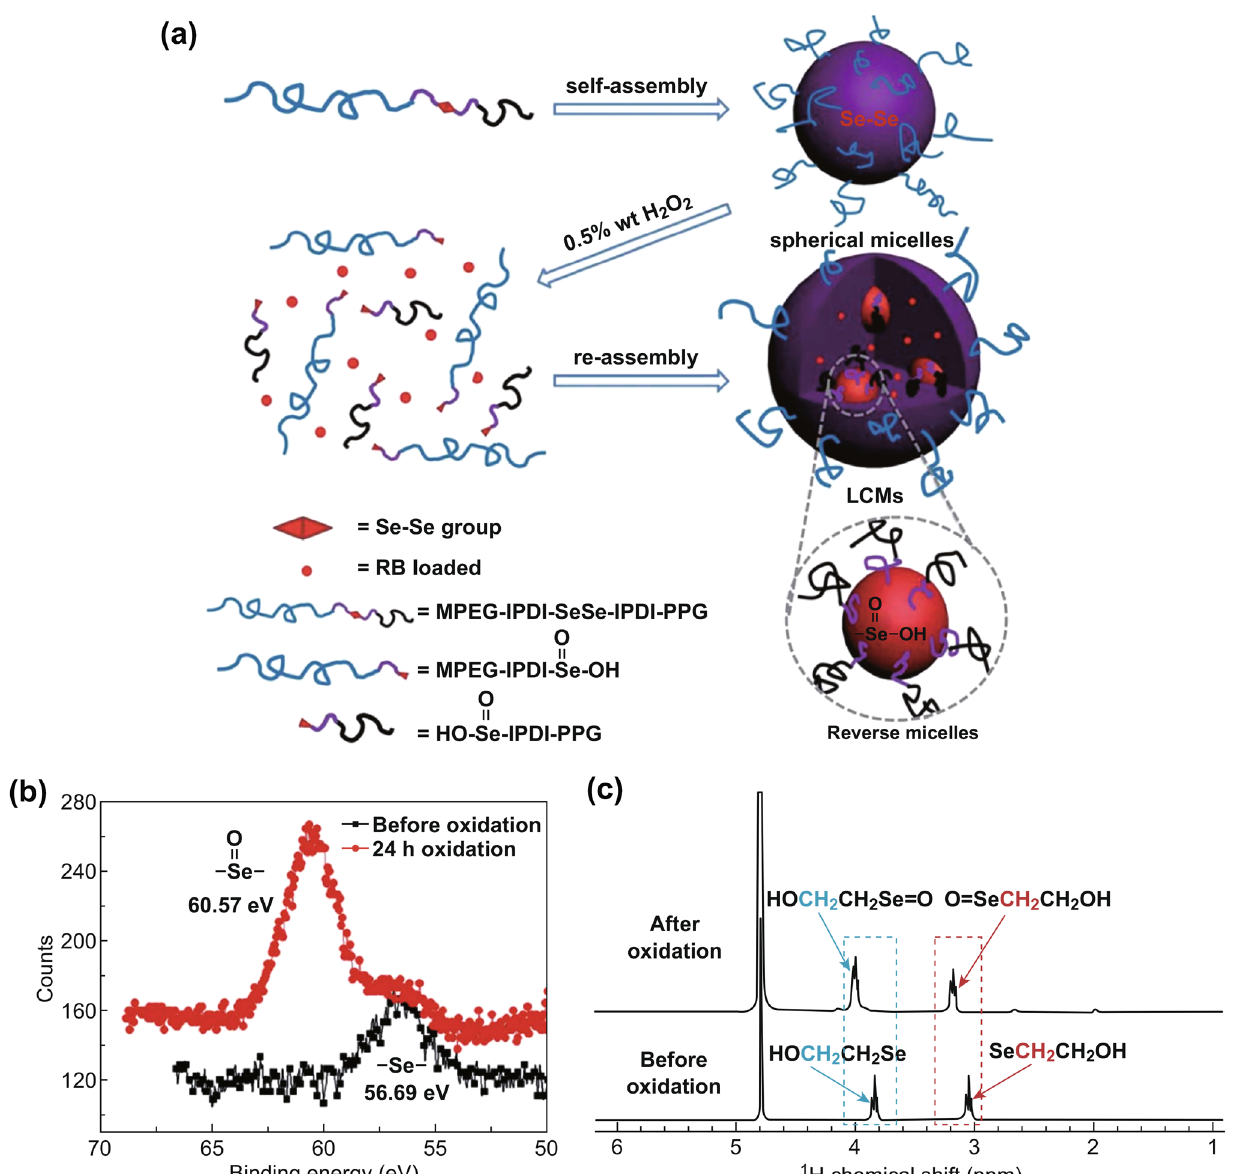
Fig. 12 a Schematic of the oxidation-responsive morphological transformation of MPEG-IPDI-Se–Se-IPDI-PPG micelles. b XPS analysis of the model compound HOCH 2 CH 2 SeSeCH 2 CH 2 OH before and after oxidation in 0.5 wt% H 2 O 2 solution. c 1 H-NMR spectra of the model com- pound